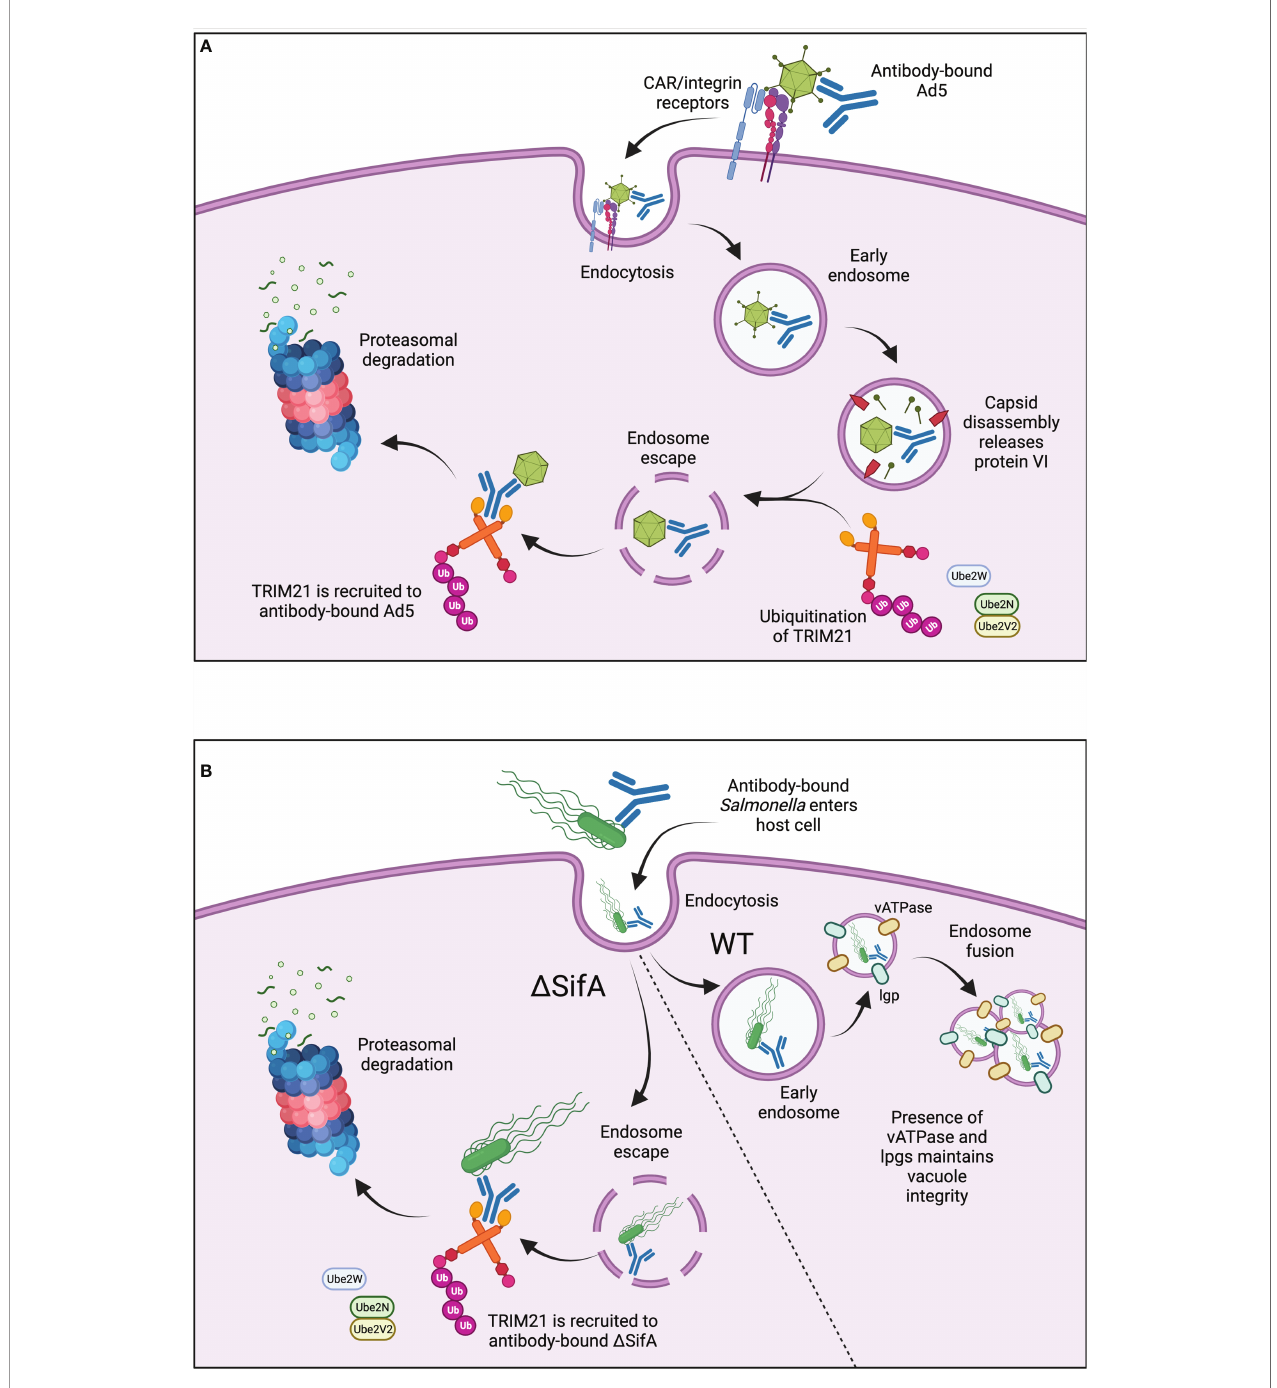
FIGURE 2 | (A) TRIM21 in antiviral responses. TRIM21 is recruited to cytosolic antibody-bound-Ad5 after virus entry into the cell. Ad5 binds to CAR/ a v integrin receptors at the cell surface, triggering capsid disassembly upon cell entry. Lytic protein VI is released leading to endosomal disassembly and “ endosomal escape ” of the antibody-bound-Ad5. Active, ubiquitinated TRIM21 binds to the Fc region of the antibody and promotes subsequent proteasomal degradation. (B) TRIM21 in responses to intracellular bacteria. TRIM21 is recruited to antibody-coated SifA-mutant S. typhimurium . Wild-type S. typhimurium are protected from TRIM21- mediated degradation due to the presence of vATPase and lgps, which maintain SCV integrity and enable endosome fusion for bacterial replication. D SifA bacteria cannot maintain SCV integrity, leading to endosomal escape into the cytosol for TRIM21-mediated